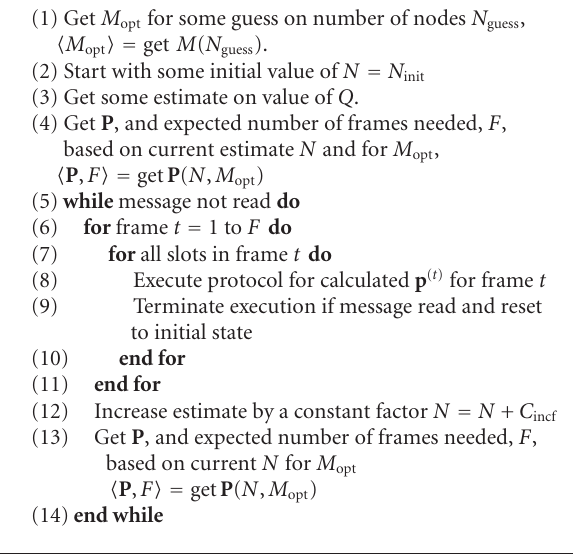
Algorithm 1: Adaptive alert